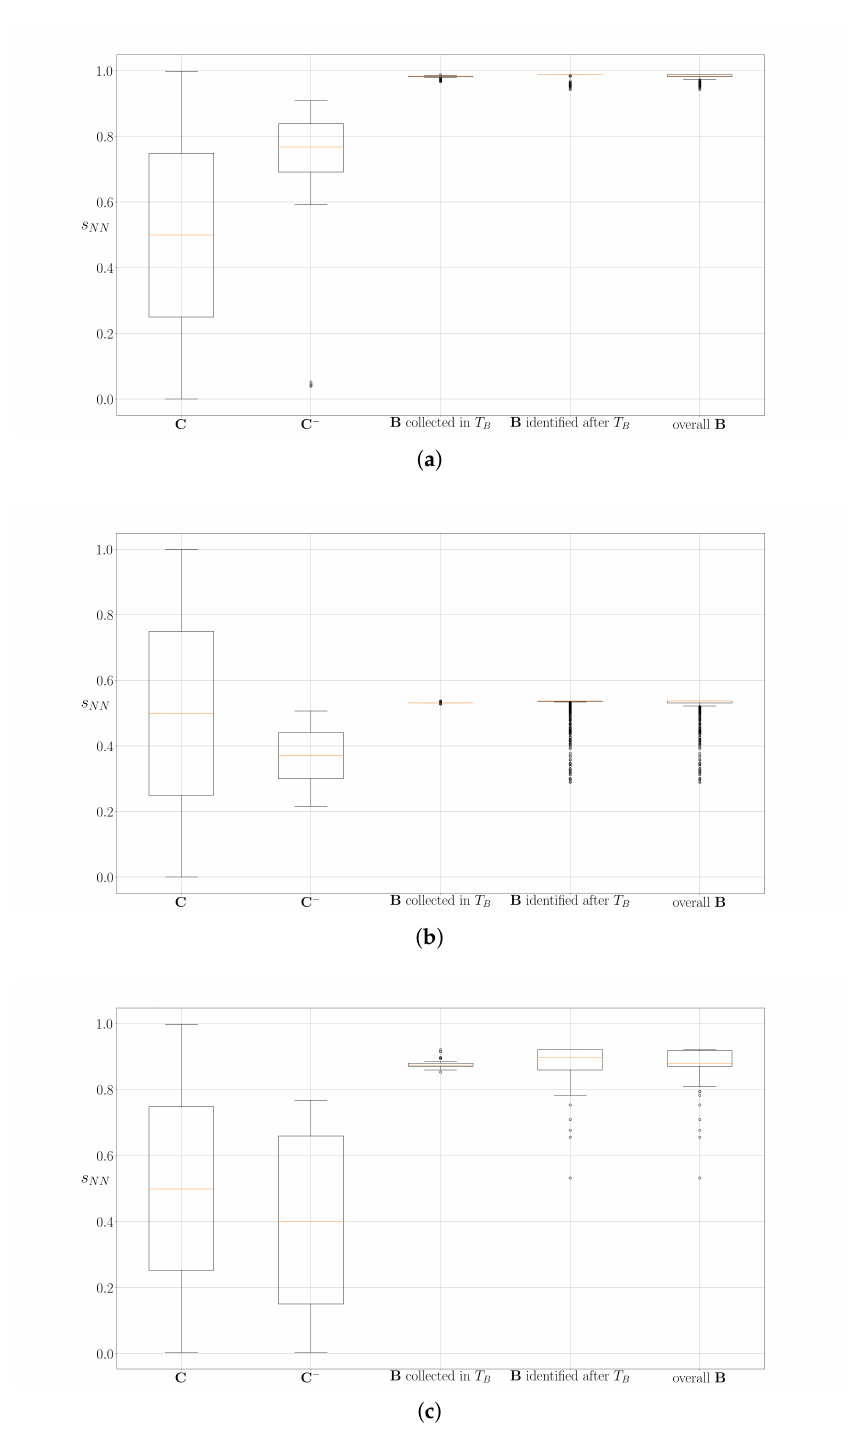
Figure 10. The distributions of OCNN scores ( s N N ) of baseline responses and the measurements in the first exposure state in three experiments, namely ( a ): Experiment 1, ( b ): Experiment 2: and ( c ): Experiment 3. In each subfigure, the first box-plot corresponds to the training set of OCNN ( C ), which is also the measurements in the first exposure state; The second box-plot corresponds to the data with Top 25% s GM score in C . This set of measurements is denoted as C − ; The third box-plot corresponds to the baseline responses collected during T B ; The fourth box-plot corresponds to the identified baseline responses after T B ; The fifth box-plot corresponds to all data labeled as baseline responses. In all three experiments shown here, the s NN values of the baseline responses are distributed over a very narrow interval, and this interval does not overlap with C −